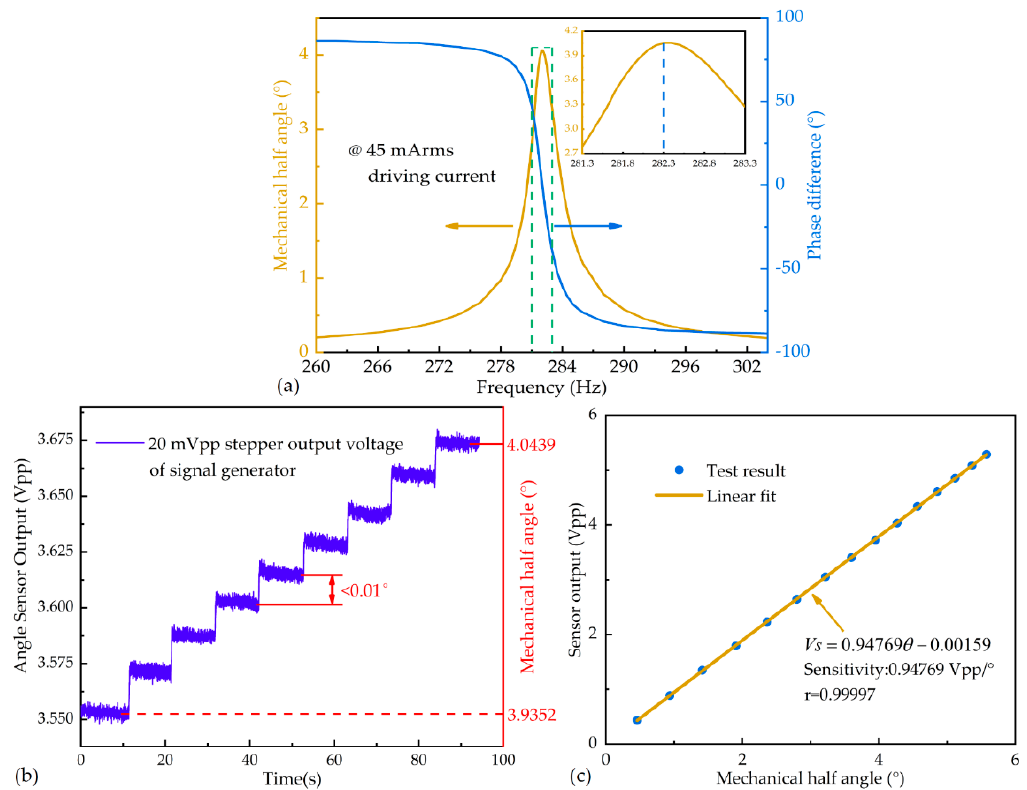
Figure 2. Characteristic test results of the FR4-based electromagnetic scanning micrograting. ( a ) Frequency response characteristics of the scanning micrograting; ( b ) resolution of the integrated angle sensor; ( c ) relationship between the integrated angle sensor output voltage and the mechanical half angle of scanning micrograting. Note: All the voltages are measured as peak values.